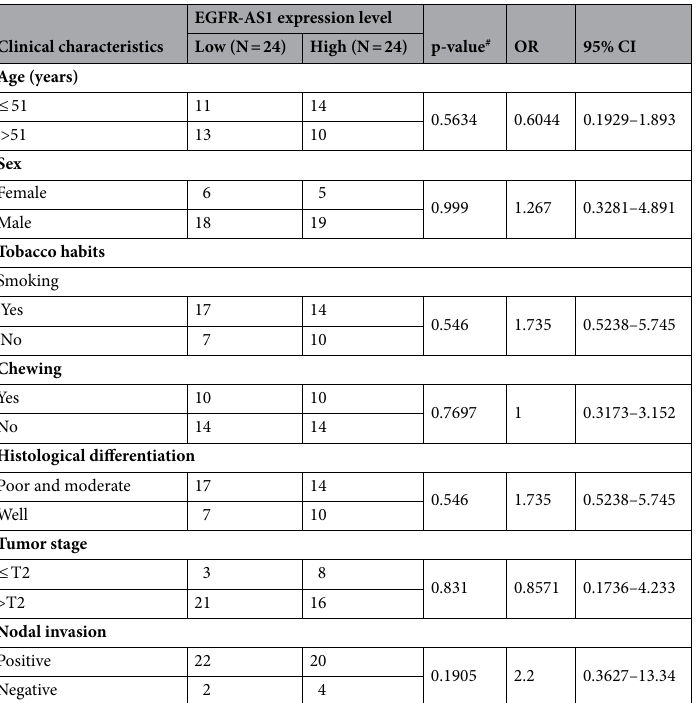
Table 3. Relationship between EGFR-AS1 expression and clinicopathological characteristics in oral cancer patients. # Fisher’s exact test with two tailed P value.